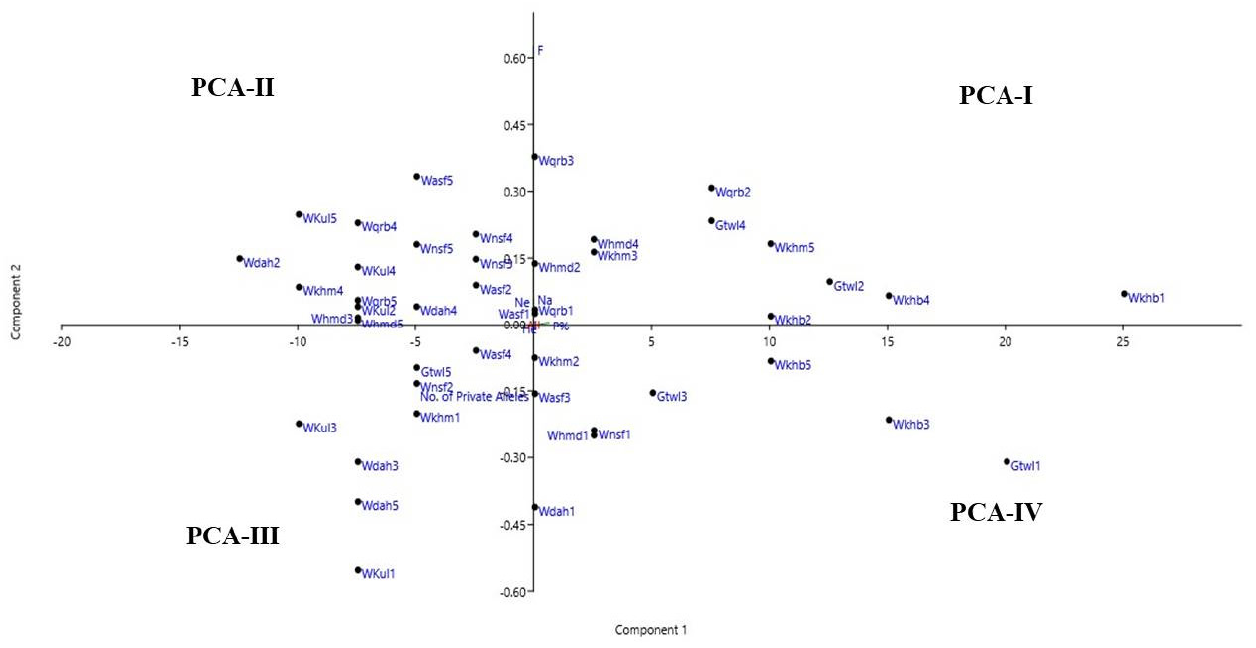
Figure 3. Principle component analysis (PCA) implemented for the studied populations of R. epapposum